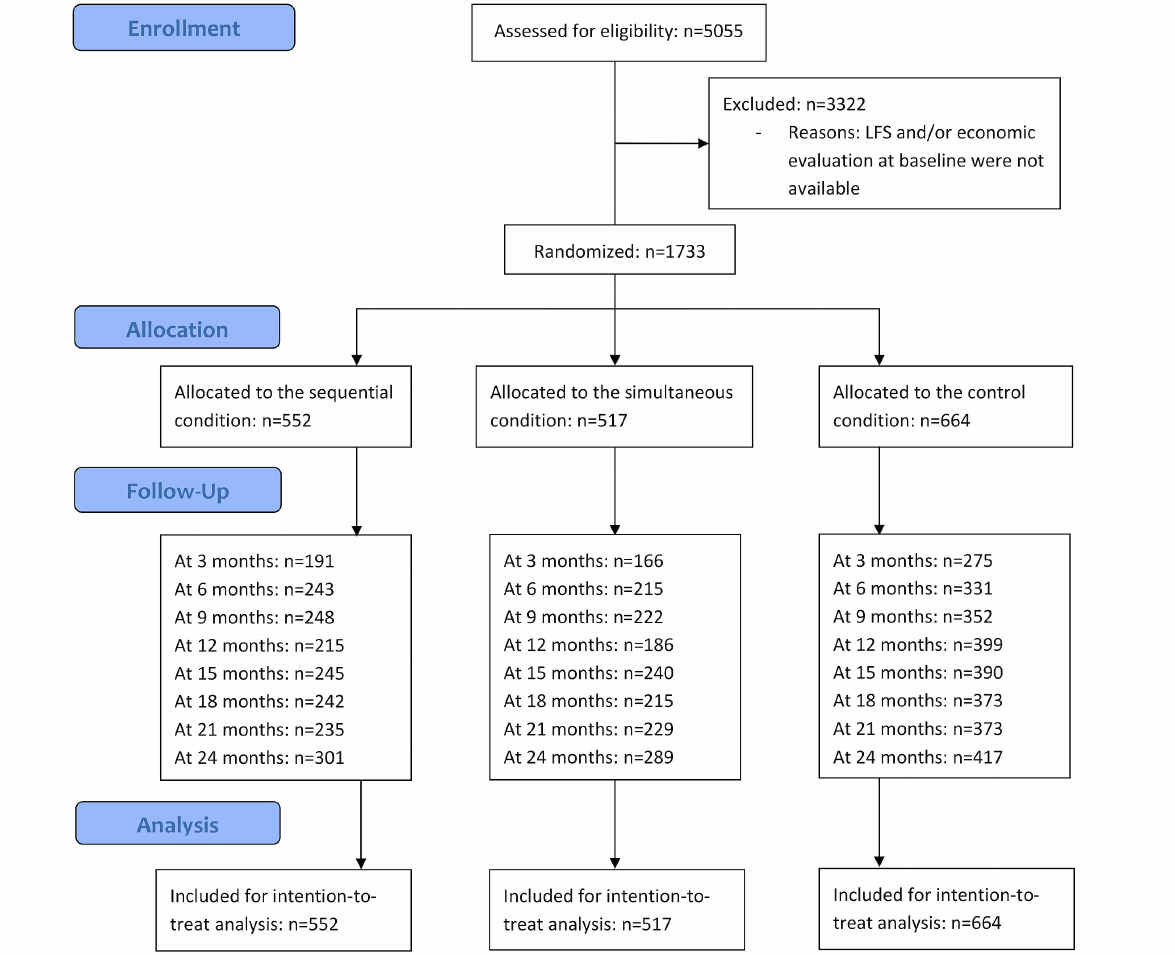
Figure 1. Flow diagram of the economic